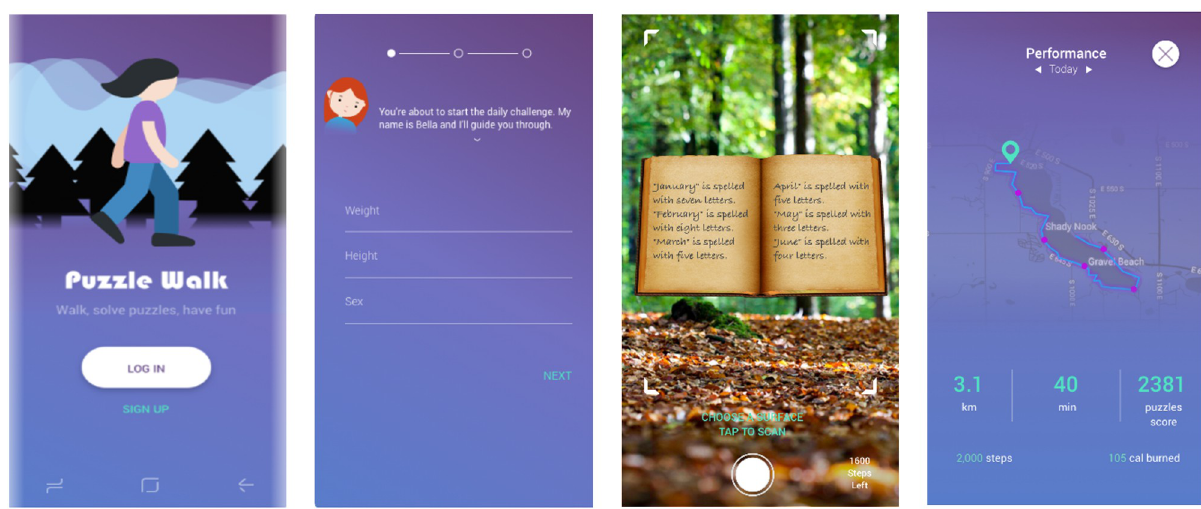
Fig 3. Screenshots of the high-fidelity prototype (e.g., sign up, onboarding, gathering a hint, feedback on performance).